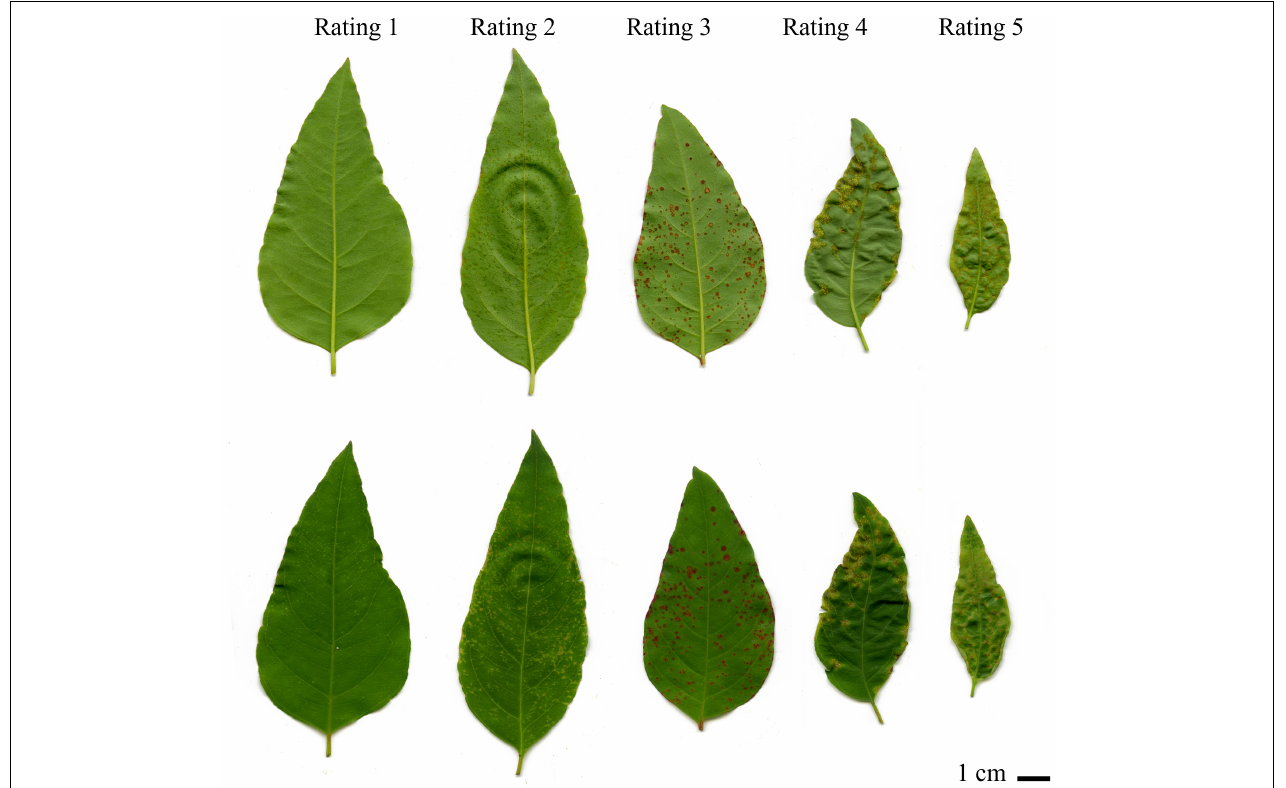
FIGURE 1 | Disease progression of Eucayptus grandis in response to Austropuccinia psidii . The top leaves show the adaxial while the bottom shows the abaxial view of the leaves. Rating one was considered resistant while ratings two to five were considered susceptible to A. psidii. Rating one showed slight chlorotic flecking, progressing in rating two and three where the flecking became necrotic and uredinia pustules began to form. Uredinia pustules became more apparent in rating four and severe pustules began forming by rating five. Rating one and rating five were selected for further